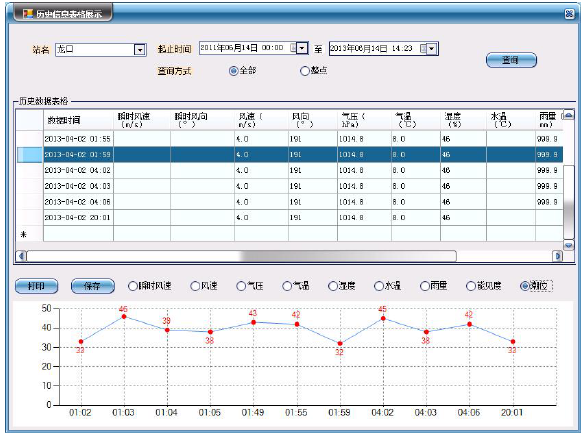
Figure 4. The representation of observation station’s information based on